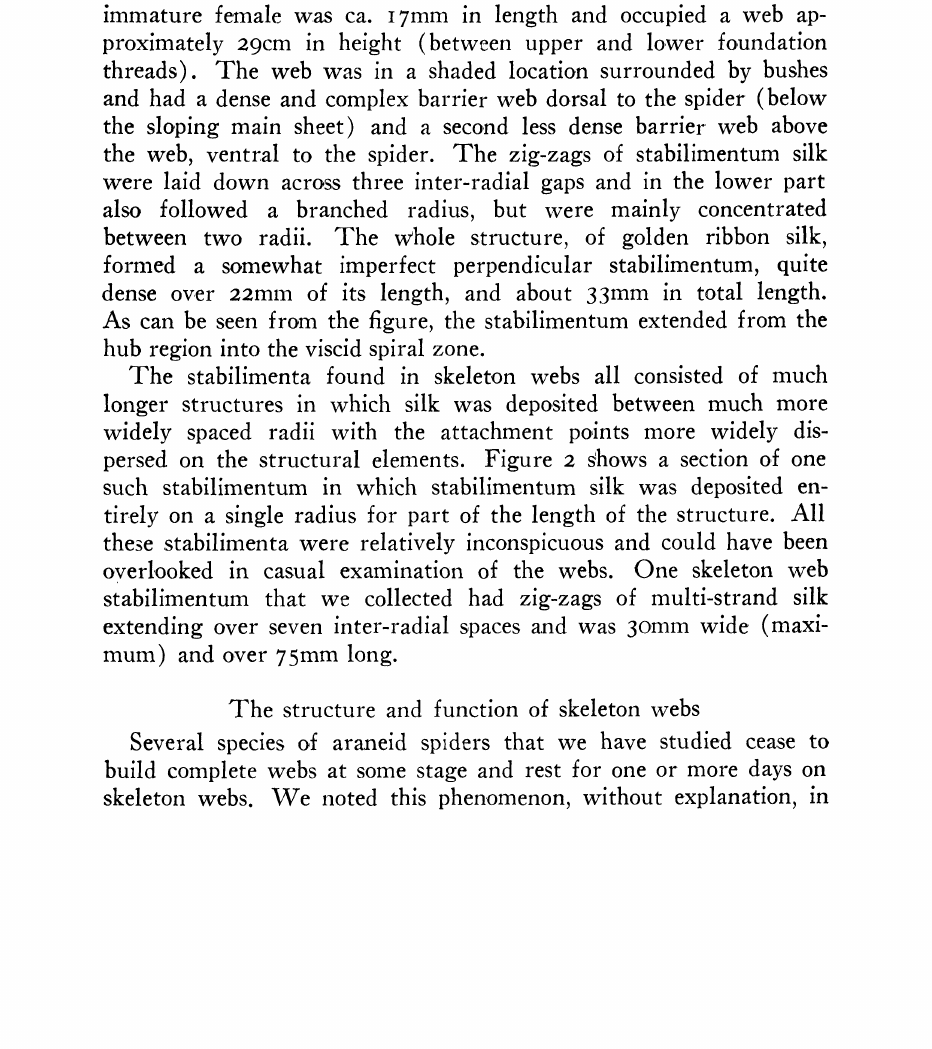
shows the stabilimentum in the co.mplete web. The immature female w.a.s ca. I7mm in length and occupied a web